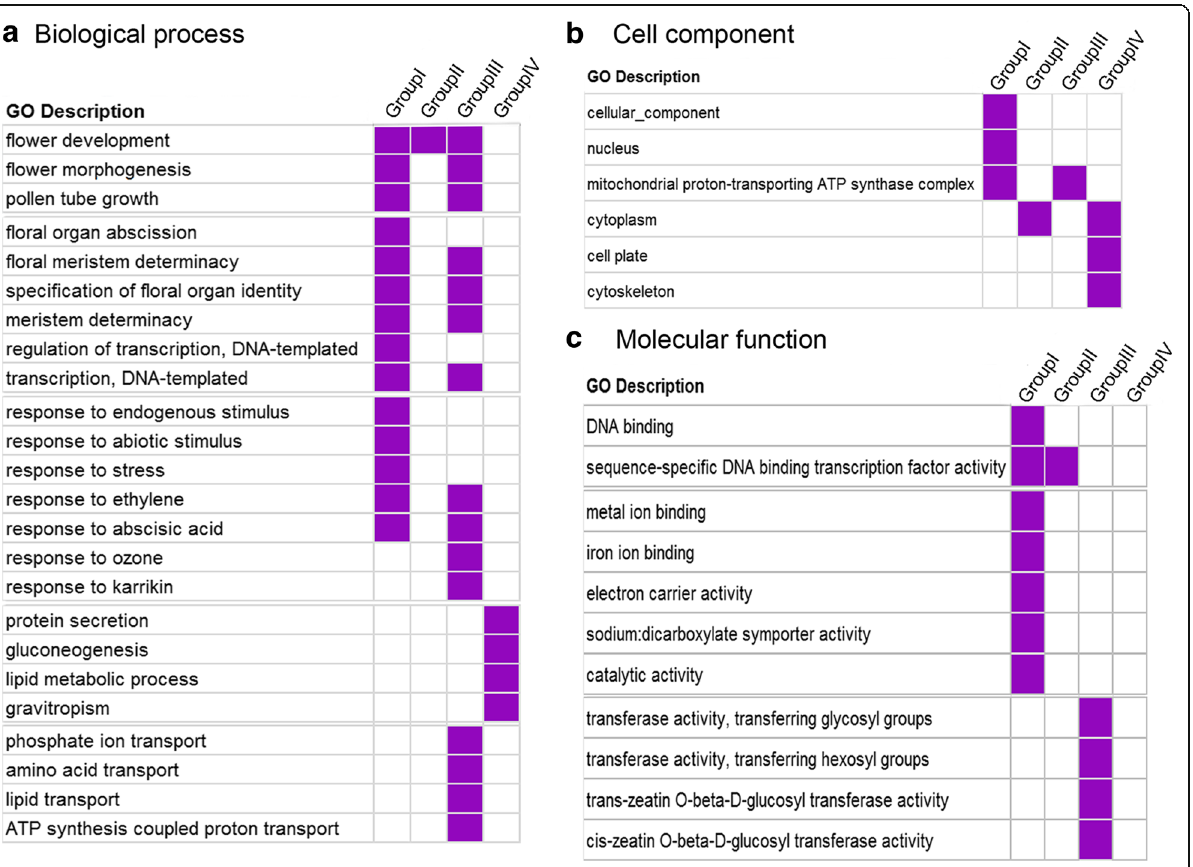
Fig. 5 GO classification of differentially expressed genes in four groups during meiosis. a Significant GO terms of biological process category in four groups. b Significant GO categories of cell component category in four groups. c Significant GO categories of molecular function category in four